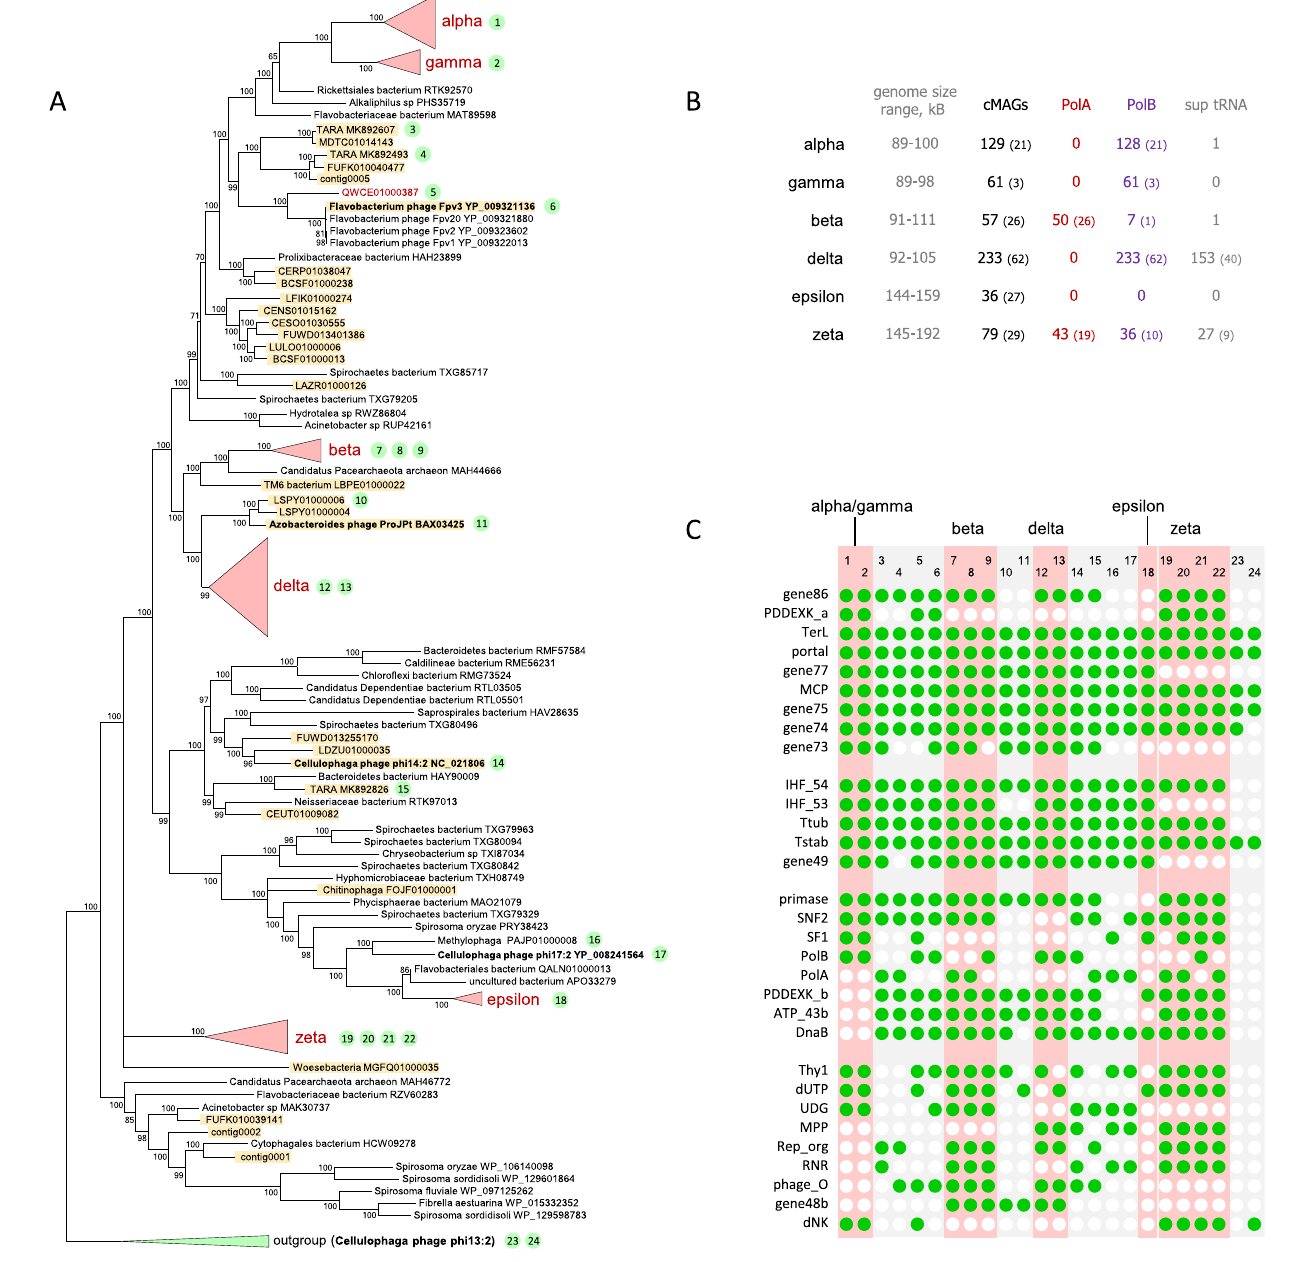
Fig. 1 The crAss-like phage assemblage. a Phylogenetic tree of the TerL protein of crAss-like phages. CrAss-like groups are marked with red color. Previously analyzed crAss-like sequences are highlighted in yellow. Cultured phages are marked with bold font. Numbers in green circles indicate genomes for which the gene conservation pattern is shown in c . b Some key genome features of CrAss-like cMAGs. In parentheses are numbers on distinct genomes (sharing <90% of similarity at the DNA level). c Pattern of gene conservation in crAss-like phages. TerL terminase large subunit, portal portal protein, gene77 putative structural protein (gene 77), MCP major capsid protein, gene75 putative structural protein (gene 75), gene74 putative structural protein (gene 74), gene73 putative structural protein (gene 73), IHF_54 IHF subunit (gene 54), IHF_53 IHF subunit (gene 53), Ttub Tail tubular protein (P22 gp4- like), Tstab tail stabilization protein (P22 gp10-like), gene49 uncharacterized protein (gene 49), gene86 putative structural protein (gene 86), PDDEXK PD-(D/E)XK family nuclease, DnaB phage replicative helicase, DnaB family, primase DnaG family primase, SNF2 SNF2 helicase, SF1 SF1 helicase, ATP_43b AAA domain ATPase, PolB DNA polymerase family B, PolA DNA polymerase family A, Thy1 thymidylate synthase, dUTP dUTPase, UDG Uracil-DNA glycosylase, MPP metallophosphatase, Rep_Org replisome organizer protein, RNR ribonucleotide reductase, phage_O bacteriophage replication protein O (gene10 of IAS virus), gene48b phage endonuclease I, dNK deoxynucleotide monophosphate kinase.